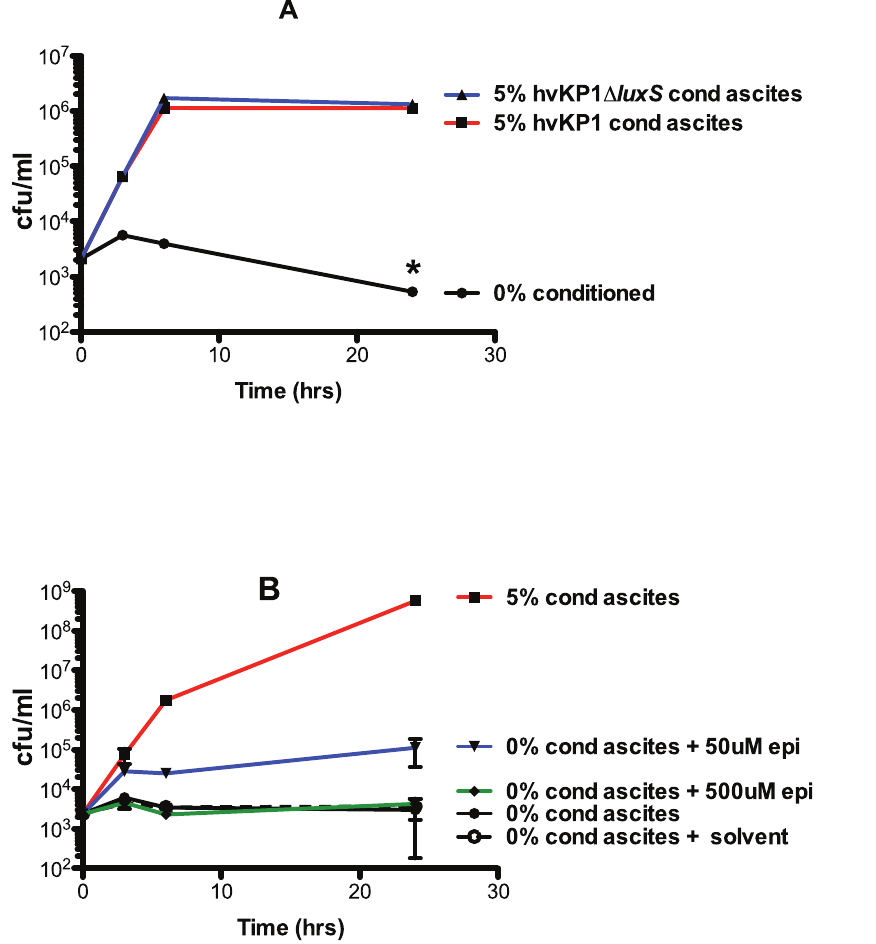
Figure 6. Neither LuxS generated AI-2 signaling molecules or the AI-3 signaling system appeared to affect the growth and/or survival of hvKP1 in conditioned ascites. The growth of hvKP1 was assessed at 0, 3, 6, and 24 hours in human ascites (batch 2). Panel A: Ascites was not supplemented (unconditioned) or supplemented with hvKP1 generated conditioned ascites (final concentration 5%) or hvKP1 D luxS generated conditioned ascites (batch 2) (final concentration 5%). There was no significant difference in the growth of hvKP1 when supplemented with either of these conditioned media. Panel B: Ascites was not supplemented (unconditioned) or supplemented with hvKP1 generated conditioned ascites (batch 2) (final concentration 5%) or epinephrine (final concentrations 50 m M and 500 m M). There was no significant difference in the growth of hvKP1 with the addition of either of these supplements. Data are Mean 6 S.E.M.; N=2–3.